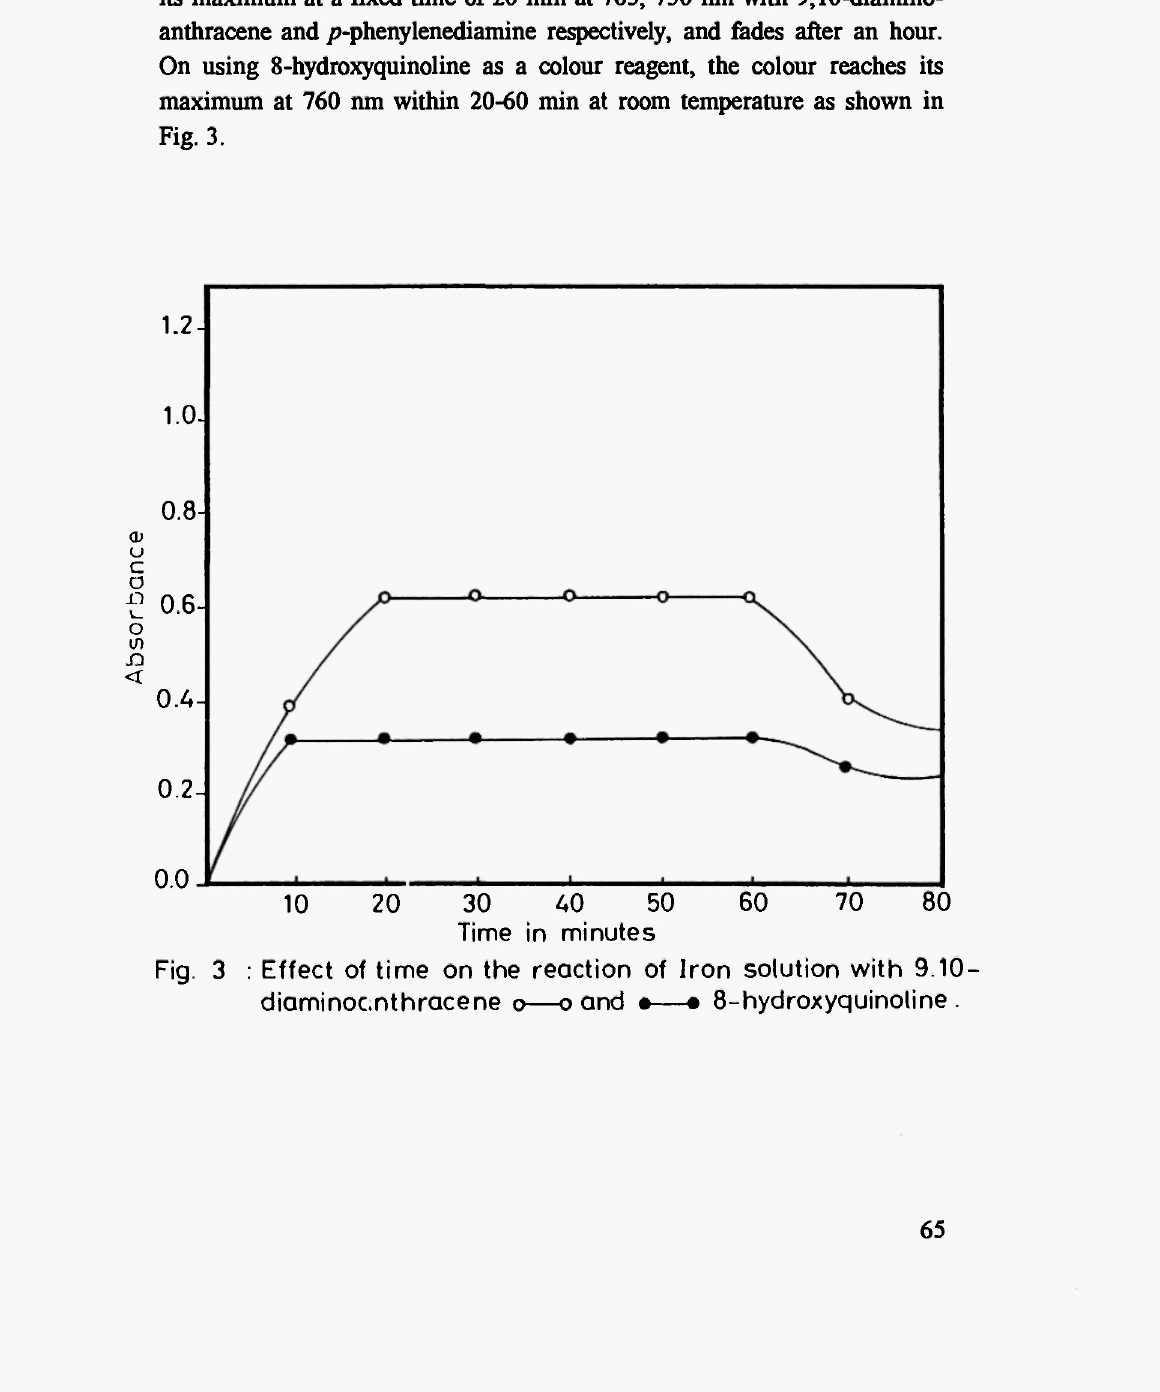
Fig. 3 : Effect of time on the reaction of Iron solution with 9.10- diaminoc.nthracene ο —ο and · —· 8-hydroxyquinoline